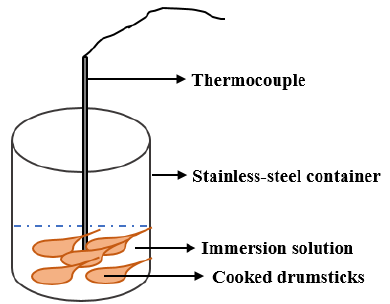
Figure 1. Immersion vacuum cooling equipment.